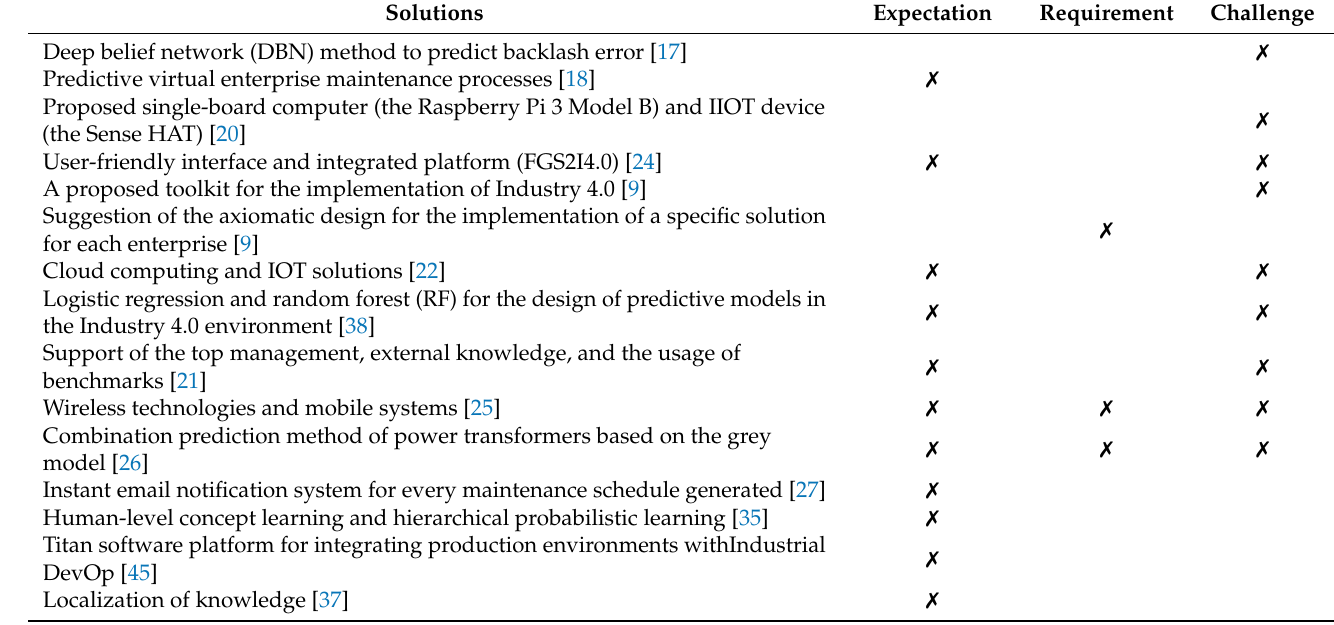
Table 4. Proposed solutions of the previous studies based on meeting the expectations, requirements, and challenges. Solutions Expectation Requirement